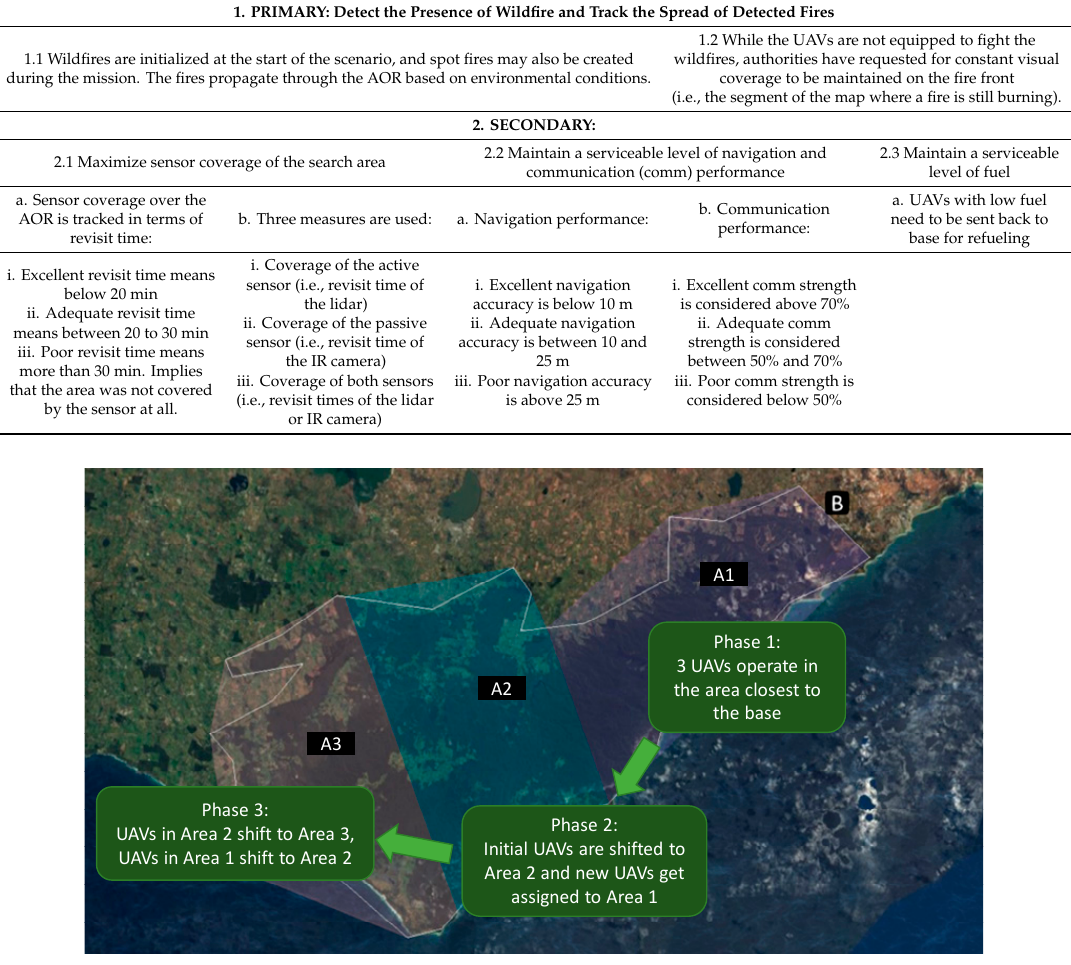
Figure 3. Mission concept illustrating the Unmanned Aerial Vehicles (UAVs) bounding strategy.